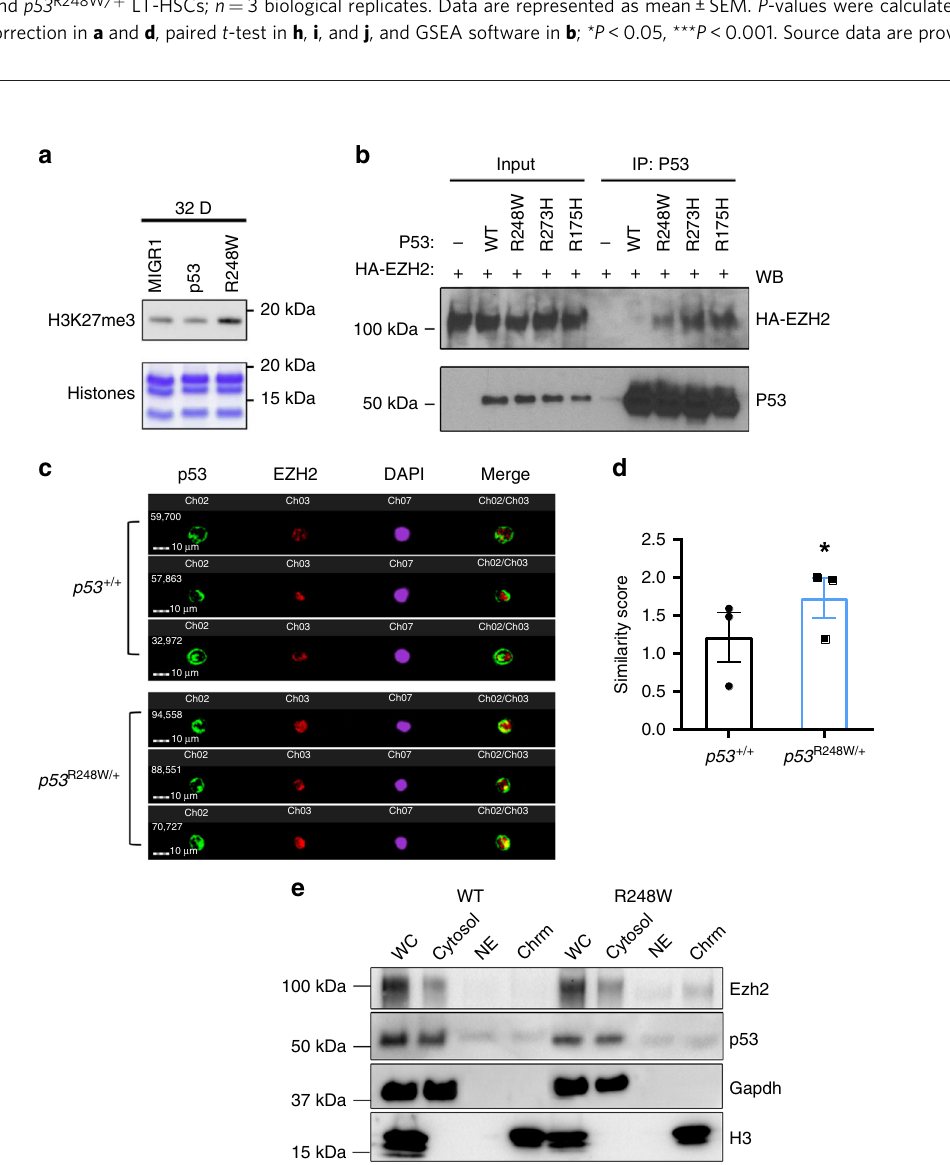
Fig. 5 Mutant p53 enhances the association of EZH2 with the chromatin in HSPCs. a 32D cells expressing mutant p53, but not wild-type (WT) p53, displayed increased levels of H3K27me3 as determined by immuno-blot analysis. b Several mutant p53 proteins, but not wild-type p53, show enhanced association with EZH2 as assayed by co-IP (co-immunoprecipitation) experiments. c Mutant p53 and EZH2 localization in HSPCs (Lin − Sca1 + Kit + CD150 + ) as determined by ImageStream fl ow cytometry analysis. d Quanti fi cation of p53 and Ezh2 co-localization in the nucleus of HSPCs (Lin − Sca1 + Kit + CD150 + ). A similarity feature determined the amount of overlay between p53 and Ezh2 within the DAPI mask. The higher the similarity score is, the more co- localized staining is within the nucleus; n = 3 biological replicates. e Cellular fractionation shows increased EZH2 association with the chromatin fraction in p53 mutant HSPCs. The absence of Gapdh (glyceraldehyde 3-phosphate dehydrogenase) and exclusive distribution of histone H3 in the chromatin fraction indicates no cross contamination between different cellular compartments. WC whole cell extract, Cyto cytosol, NE nuclear cytosol, Chrm chromatin. Data are represented as mean ± SEM. P -values were calculated using paired t -test in d ; * P < 0.05. Source data are provided as a Source Data fi